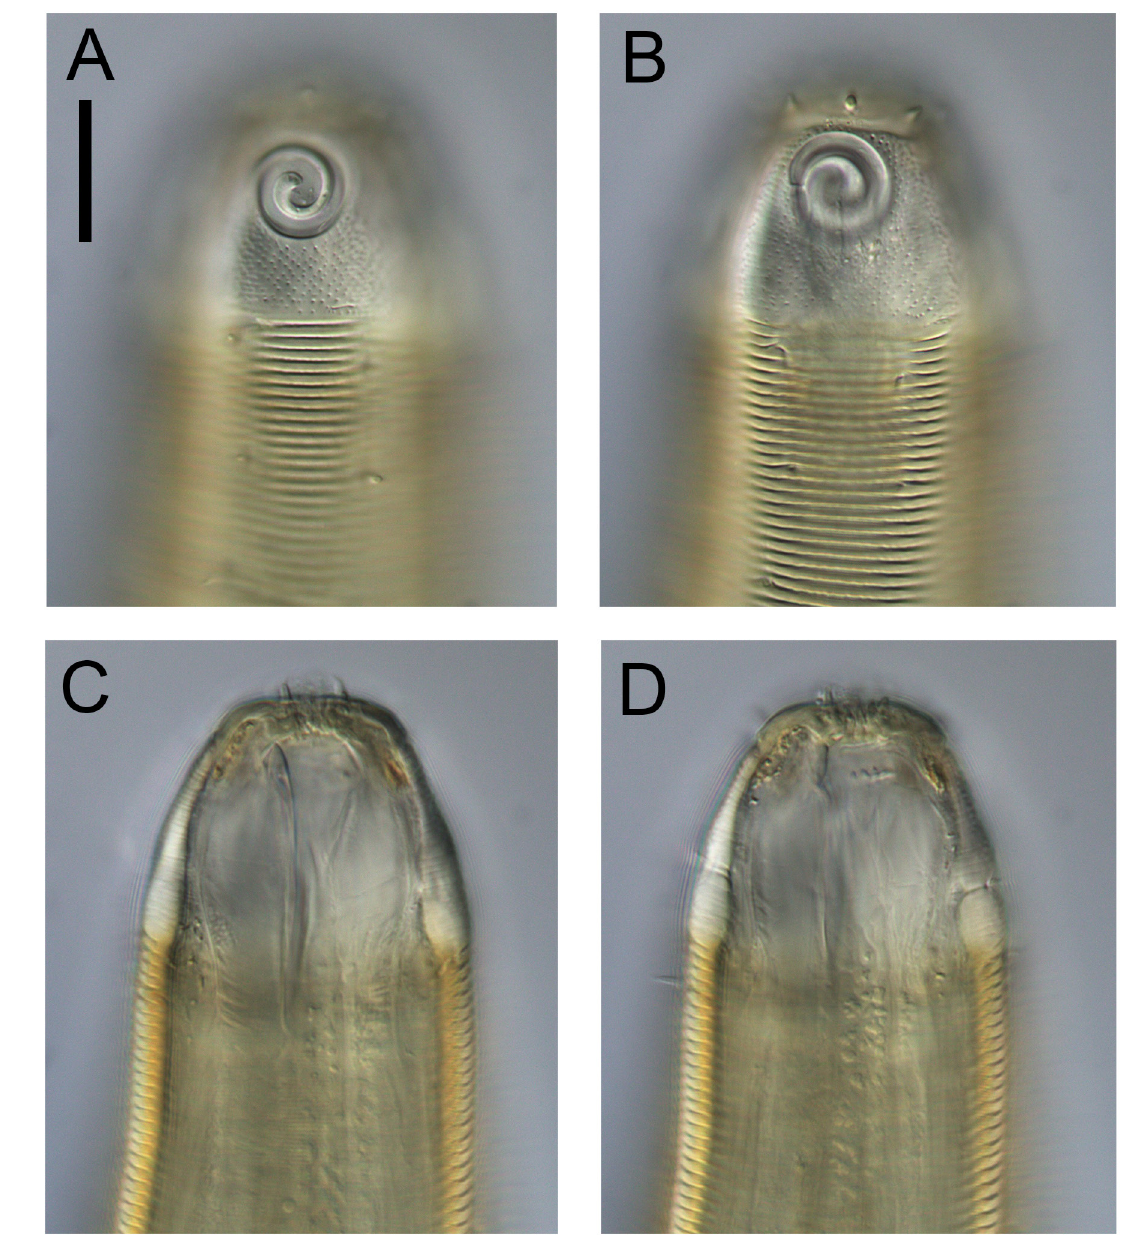
Fig. 17. Desmodora parapilosa sp. nov. Light micrographs, paratype (NIWA154923). A – B . Female cephalic region showing cuticle, amphid, and cephalic sensilla. C – D . Female cephalic region showing buccal cavity. Scale bar = 20